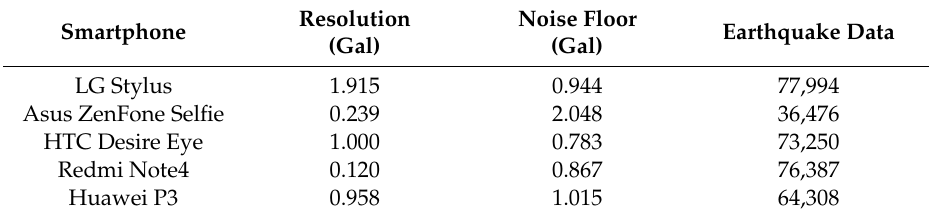
Table 1. The acceleration quality and number of the ground motions of the smartphones. Resolution Noise Floor Smartphone (Gal)